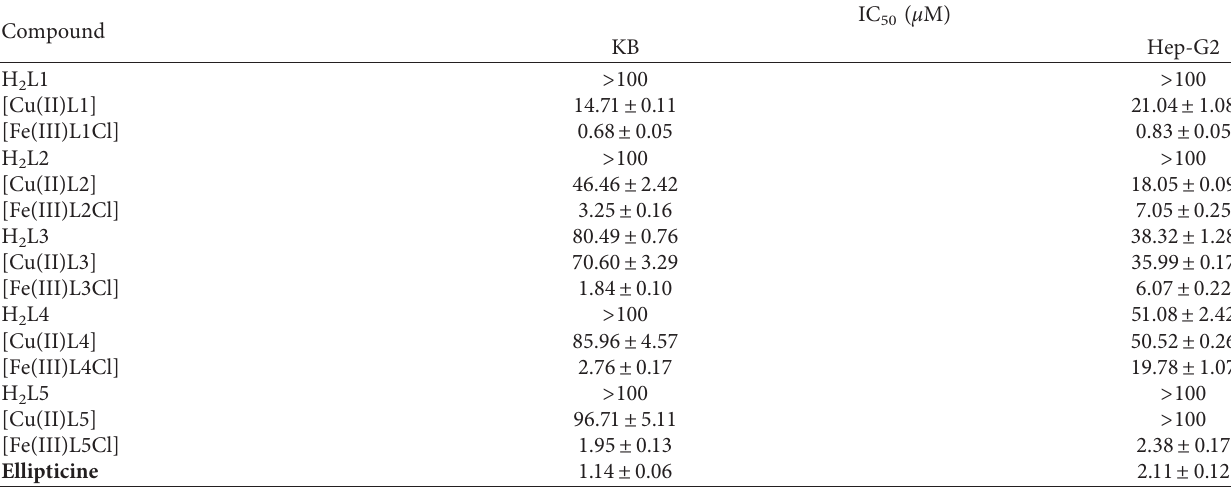
Table 1: In vitro cytotoxicity of the unsymmetrical tetradentate Schiff base Cu(II) complexes and Fe(III) complexes. Compound